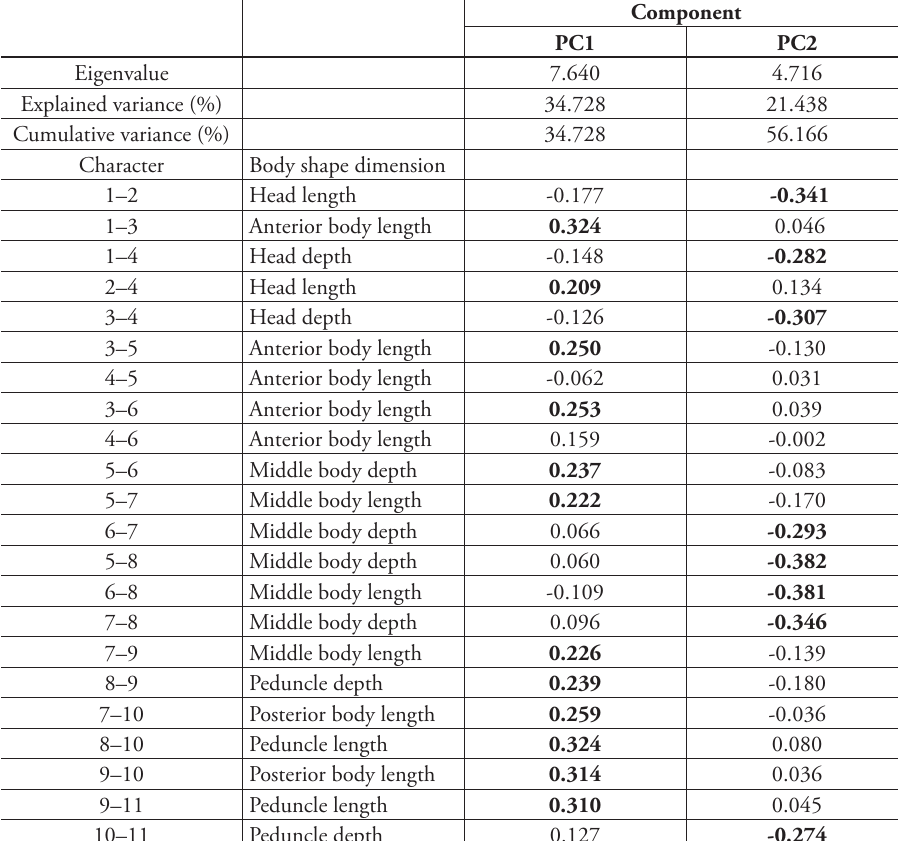
Table 2. Component loadings of the first two principal components derived from PCA based on the correlation matrix of 22 truss measurements of Trichomycterus areolatus populations from southern Chile. Characters of greater contribution on each component are in